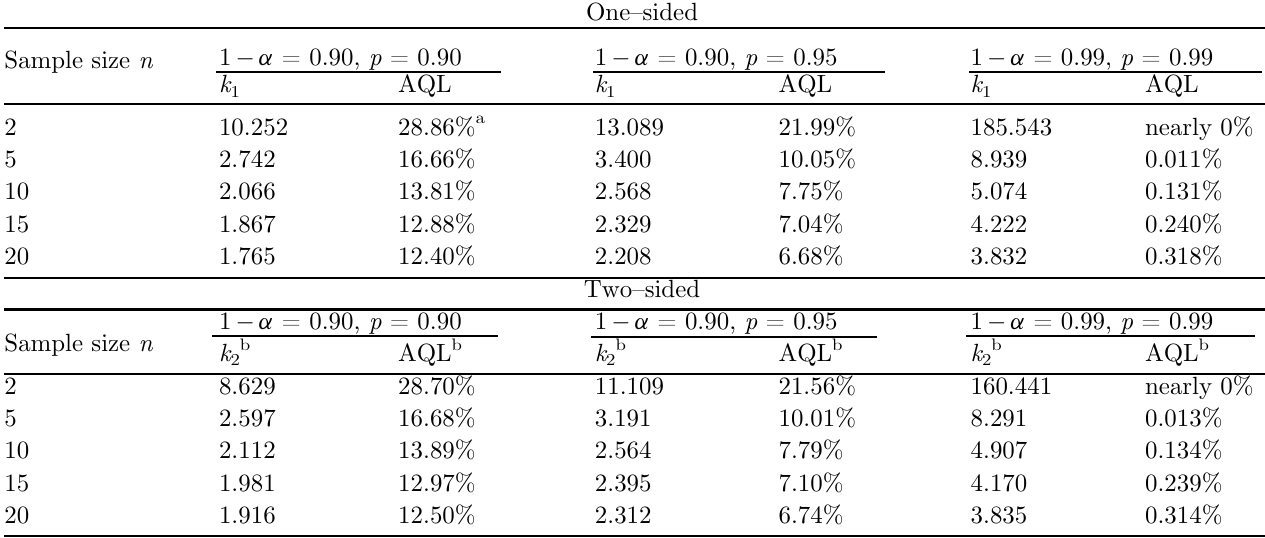
and k 1 2 One – sided